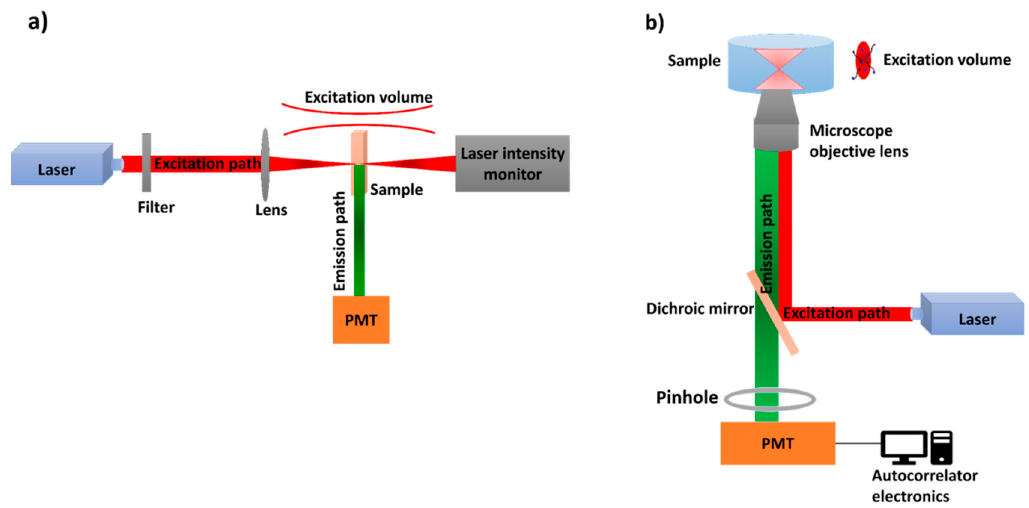
Figure 1. Schematic illustrations of the fundamental principles for a fluorescence correlation spectroscopy (FCS) experiment, ( a ) as adopted from the original paper by Magde et al. 1974 [13], and ( b ) when employing a confocal microscope setting.